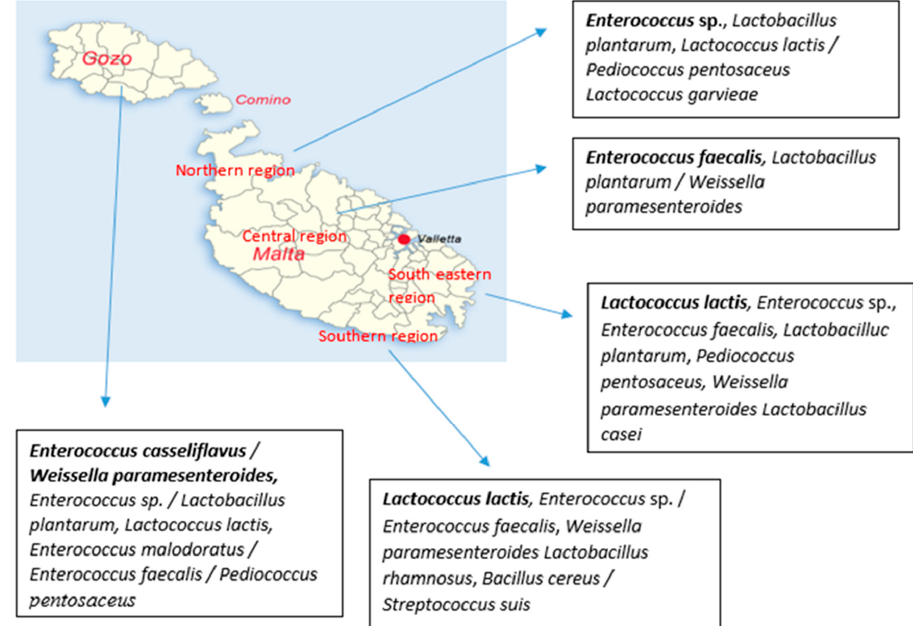
Figure 5. Geographical distribution of isolates at species level from Maltese raw milk recovered from LSA medium during summer period. The species are written from the most commonly detected to rare detected ones; bold fonts represent the most commonly detected species while the “/” was used to separate the species that were detected in the same number.